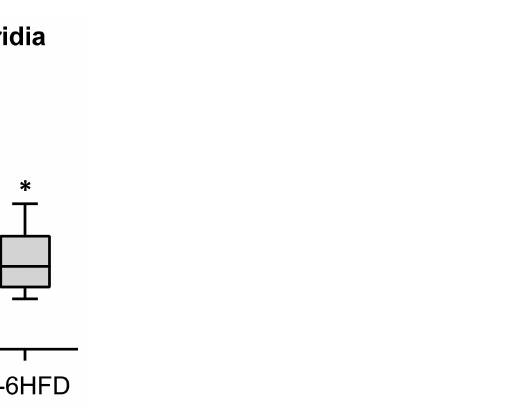
Figure 9. Chlostridia bacteria relative abundances in cecal samples of C57BL/J6 male mice at 16 weeks of age. Box and whisker plots are relative percent abundances in cecal samples of WD and n -6HFD-fed mice at 16 weeks of age. Data were analyzed utilizing the Mann–Whitney U test. Medians with an asterisk (*) differ, p < 0.05.